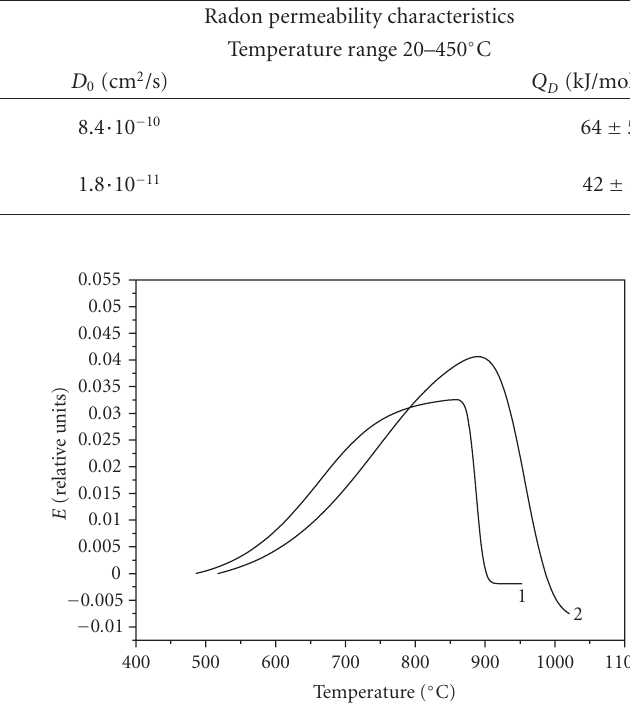
Figure 6: Temperature dependences of ln D versus 1/ T for sample A (curve 1) and sample B (curve 2).